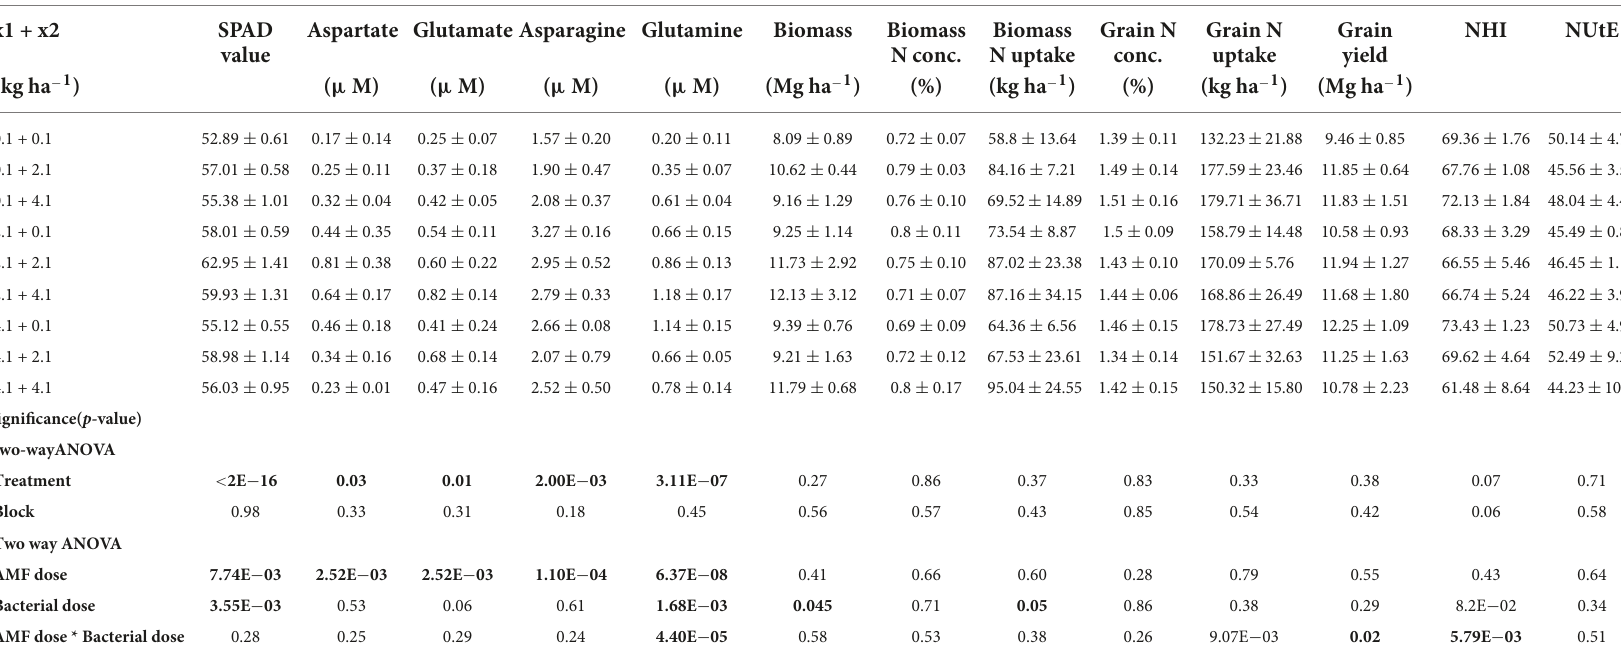
TABLE 2 Two − way ANOVA on SPAD value, amino acid concentrations, and agronomic parameters observed in the maize crop following AMF and B. megaterium treatment.